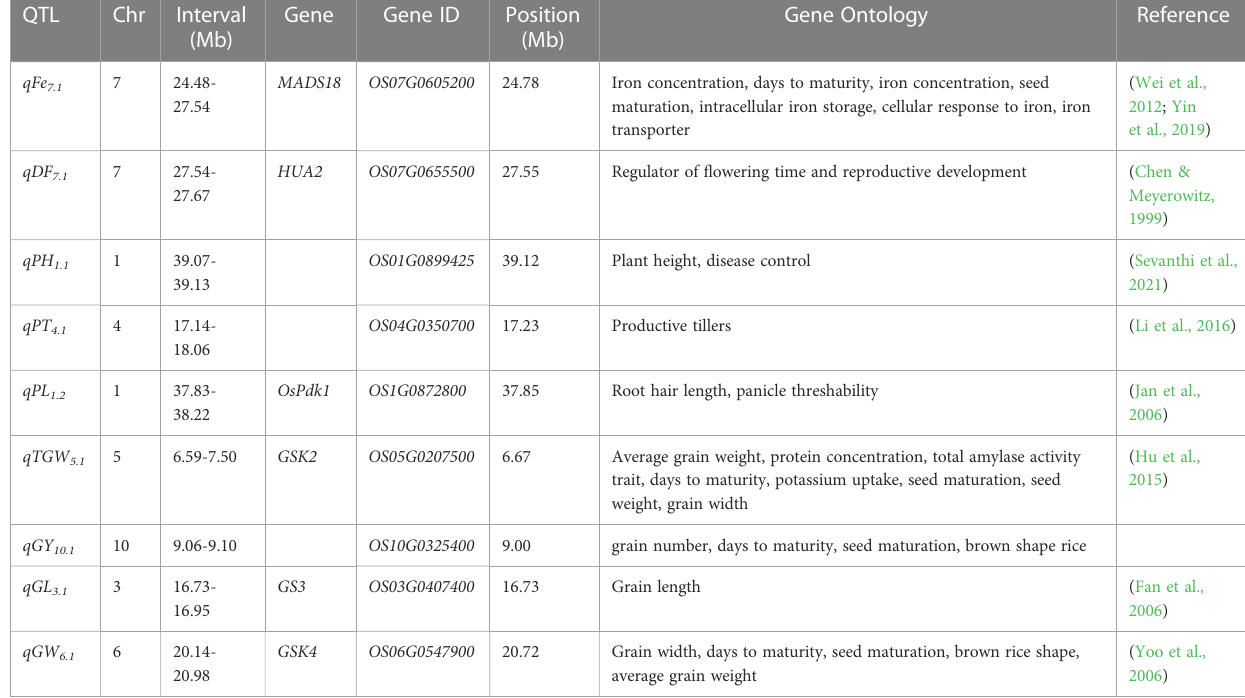
TABLE 3 Identi fi ed putative genes associated with major QTL for Zn, Fe, GY and grain-related traits of connected